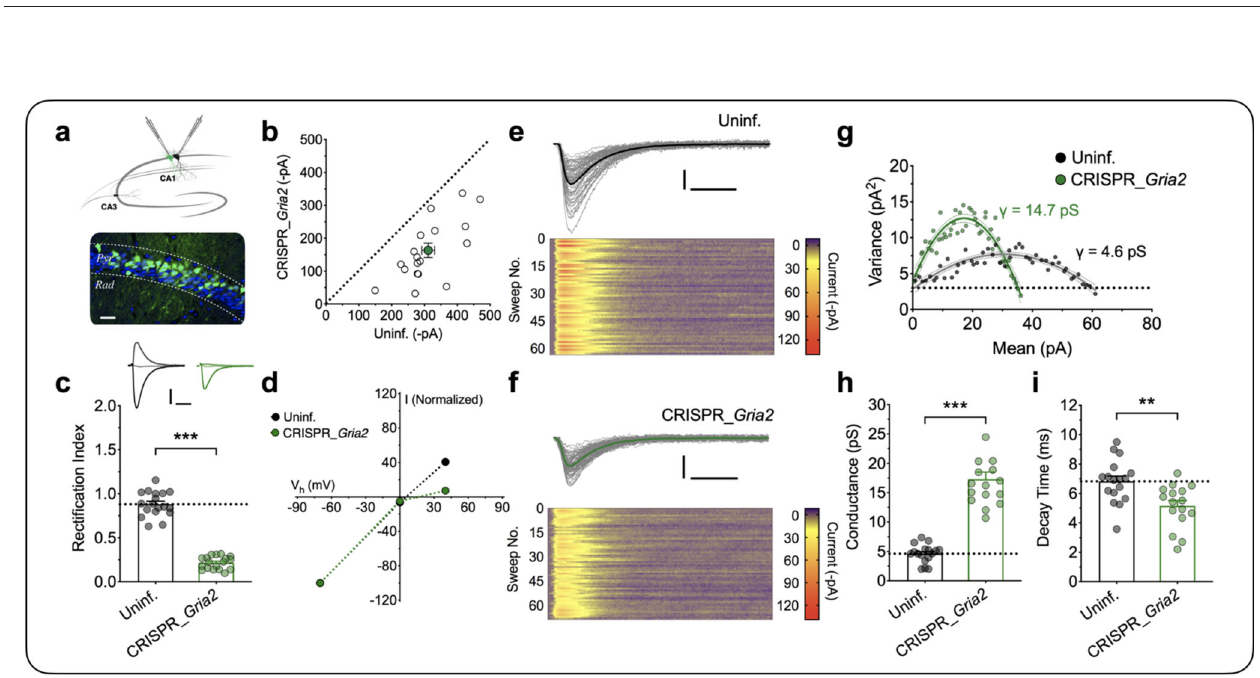
Fig. 7 CP-AMPAR characterization in CRISPR_ Gria2 knock-out neurons. a Schematic of dual whole-cell recordings for the CRISPR_ Gria2 knock-out and neighbouring uninfected (Uninf.) neurons. Sparse expression following stereotactic lentivirus injection detected by co-expressed EGFP (green); blue, DAPI staining; Pyr, stratum pyramidale; Rad, stratum radiatum. Scale bar = 30 microns. b Scatterplot shows amplitudes of AMPAR EPSCs for each pair recorded simultaneously (open circles) and the mean ± SEM ( fi lled circle; n = 18 pairs from 12 animals). c , d Quanti fi cation of the recti fi cation index for pharmacologically isolated AMPAR-mediated EPSCs and the corresponding current – voltage relationship (mean ± SEM, n = 18 pairs from 12 animals, t 17 = 17.38, p < 0.0001, two-sided paired Student ’ s t test). Scale bars: 100 pA and 10 ms. e – g Representative traces to measure the γ for the control and CRISPR_ Gria2 knock-out neurons. Individual traces (thin lines) superimposed with the average. Scale bars: 30 pA and 10 ms. The lower panels are corresponding colour-coded images of all sweeps used in the NSFA ( g ). h , i Quanti fi cation of γ ( t 31 = 10.09, p < 0.0001, two-sided unpaired Student ’ s t test) and decay time ( t 31 = 3.273, p = 0.0026, two-sided unpaired Student ’ s t test) constants ( n = 17 and 16 for Uninf. vs. CRISPR_ Gria2 knock-out neurons from 12 animals). Data are presented as mean ± SEM. Source data are provided as a Source Data fi